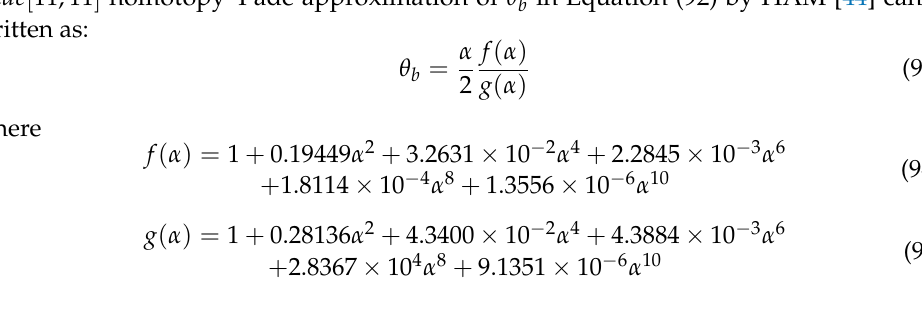
Table 4. Thirtieth-order solutions Θ